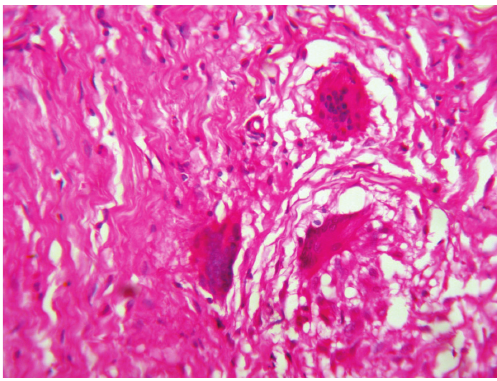
Figure 8: Photomicrograph (40x) of H&E. Resolving granulomas with giant cells.